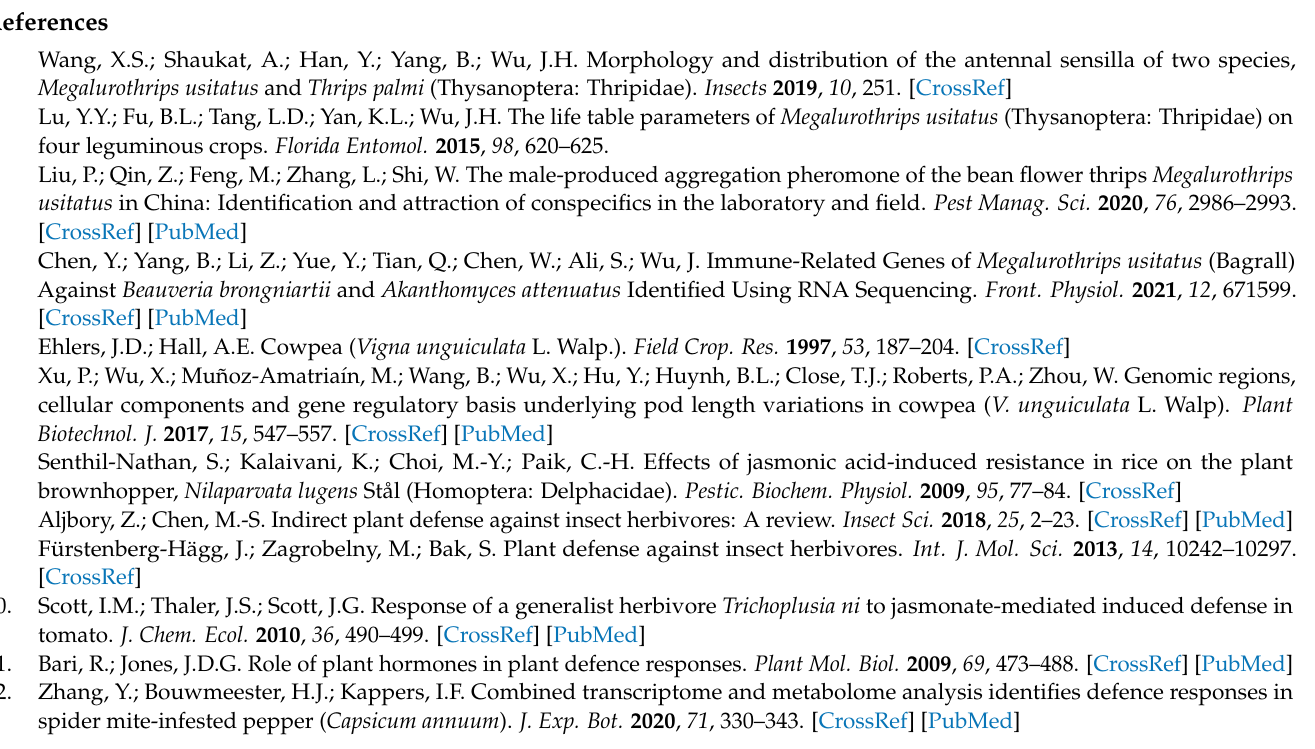
Table S7: KEGG enrichment pathway of DEGs in CK_vs_24H; Table S8: KEGG enrichment pathway of DEGs in CK_vs_48H; Table S9: KEGG enrichment pathway of DEGs in CK_vs_JA; Table S10: KEGG enrichment pathway of DEGs in Venn of DEGs; Table S11: Detail information of K-means analysis; Table S12: KEGG enrichment pathway of DEMs in CK_vs_24H; Table S13: KEGG